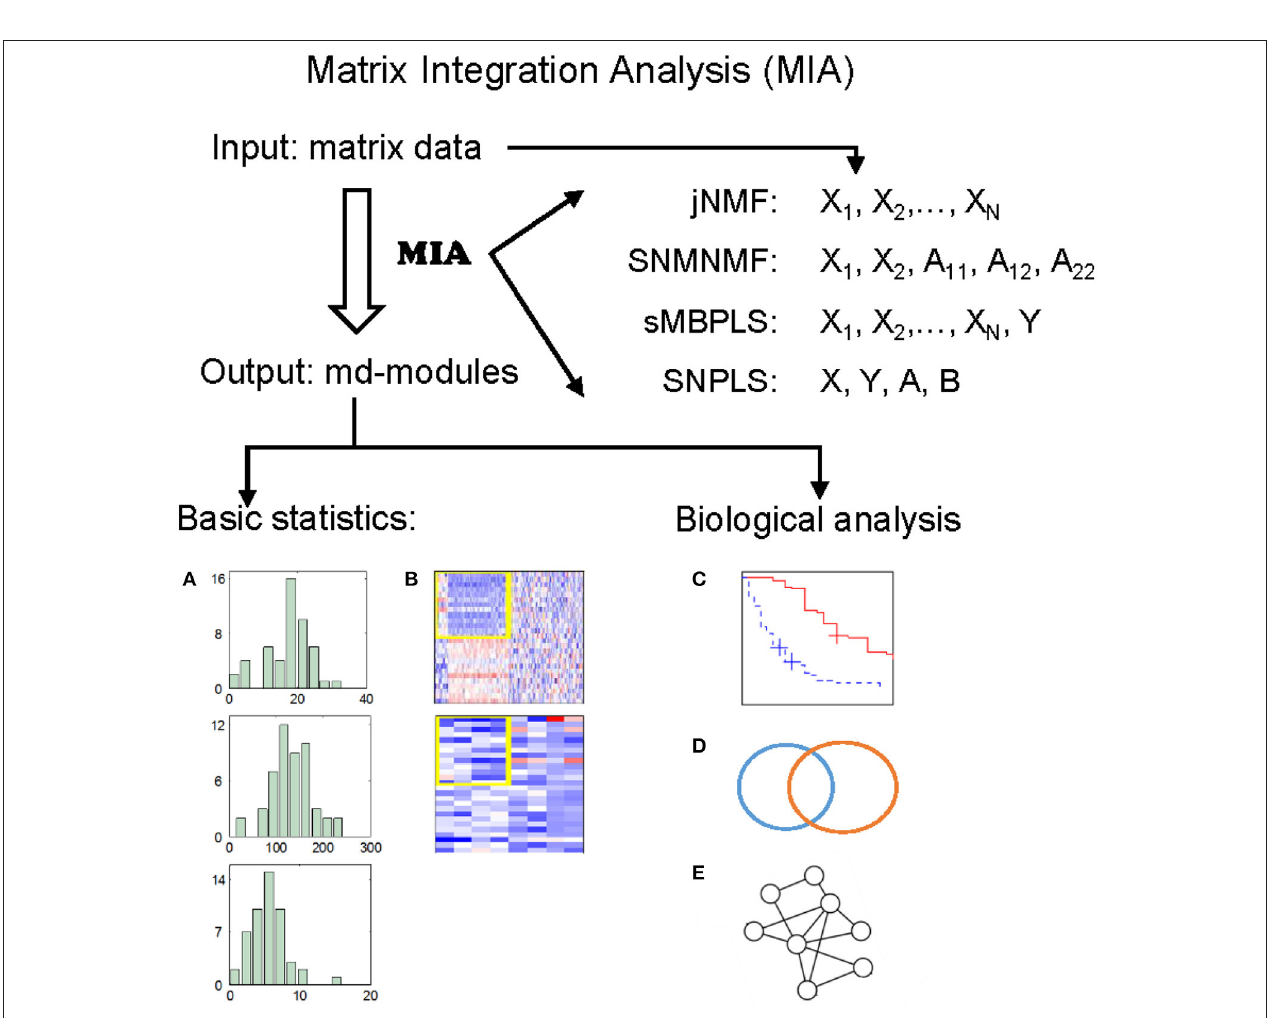
FIGURE 1 | Illustration of MIA. MIA implements four methods with multiple matrices representing different biological features on the same samples (and prior network knowledge) as input, and discovers different types of multi-dimensional modules (md-modules) as output. MIA also provides several basic statistics about the md-modules, such as their sizes, member lists, size distributions (A), and heatmaps (B) . The reported md-modules can be easily adapted for further biological analysis such as survival analysis (C) , various enrichment analysis (D), and network analysis (E) .